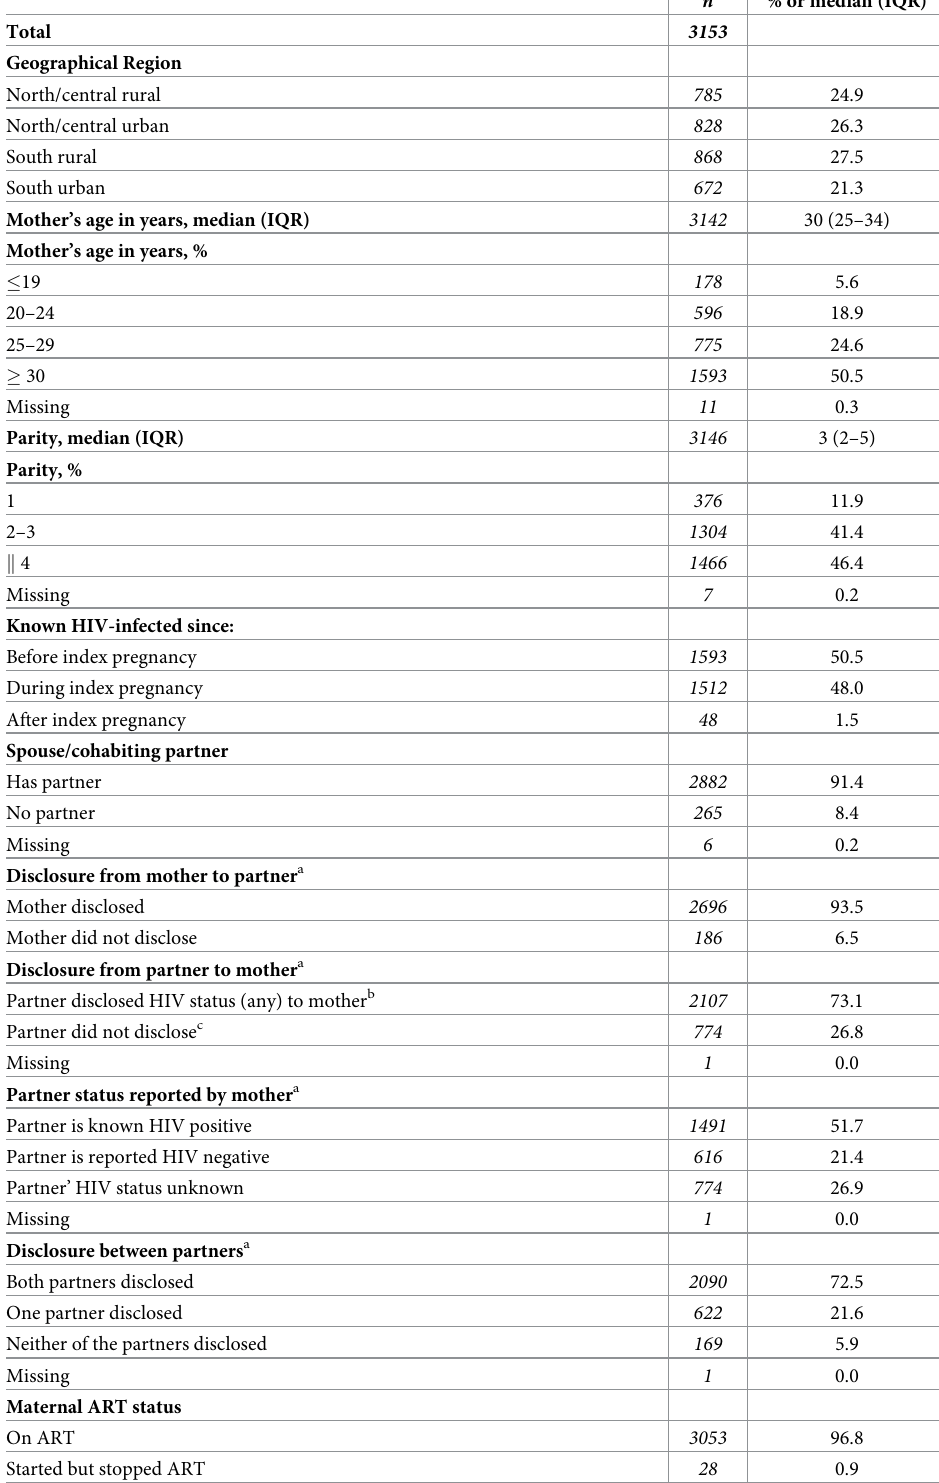
Table 1. Characteristics of postpartum HIV-infected